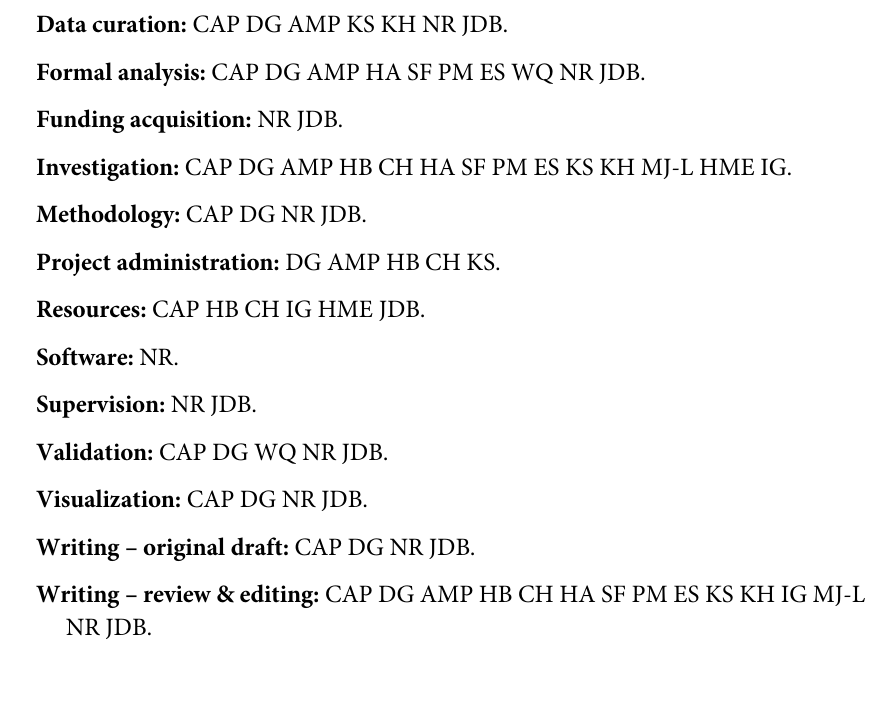
S17 Table. Sensitivity and specificity of decrease in TP53 mutant allele fraction and CA- 125 for predicting 6-mo time to progression following one and two cycles of chemother-